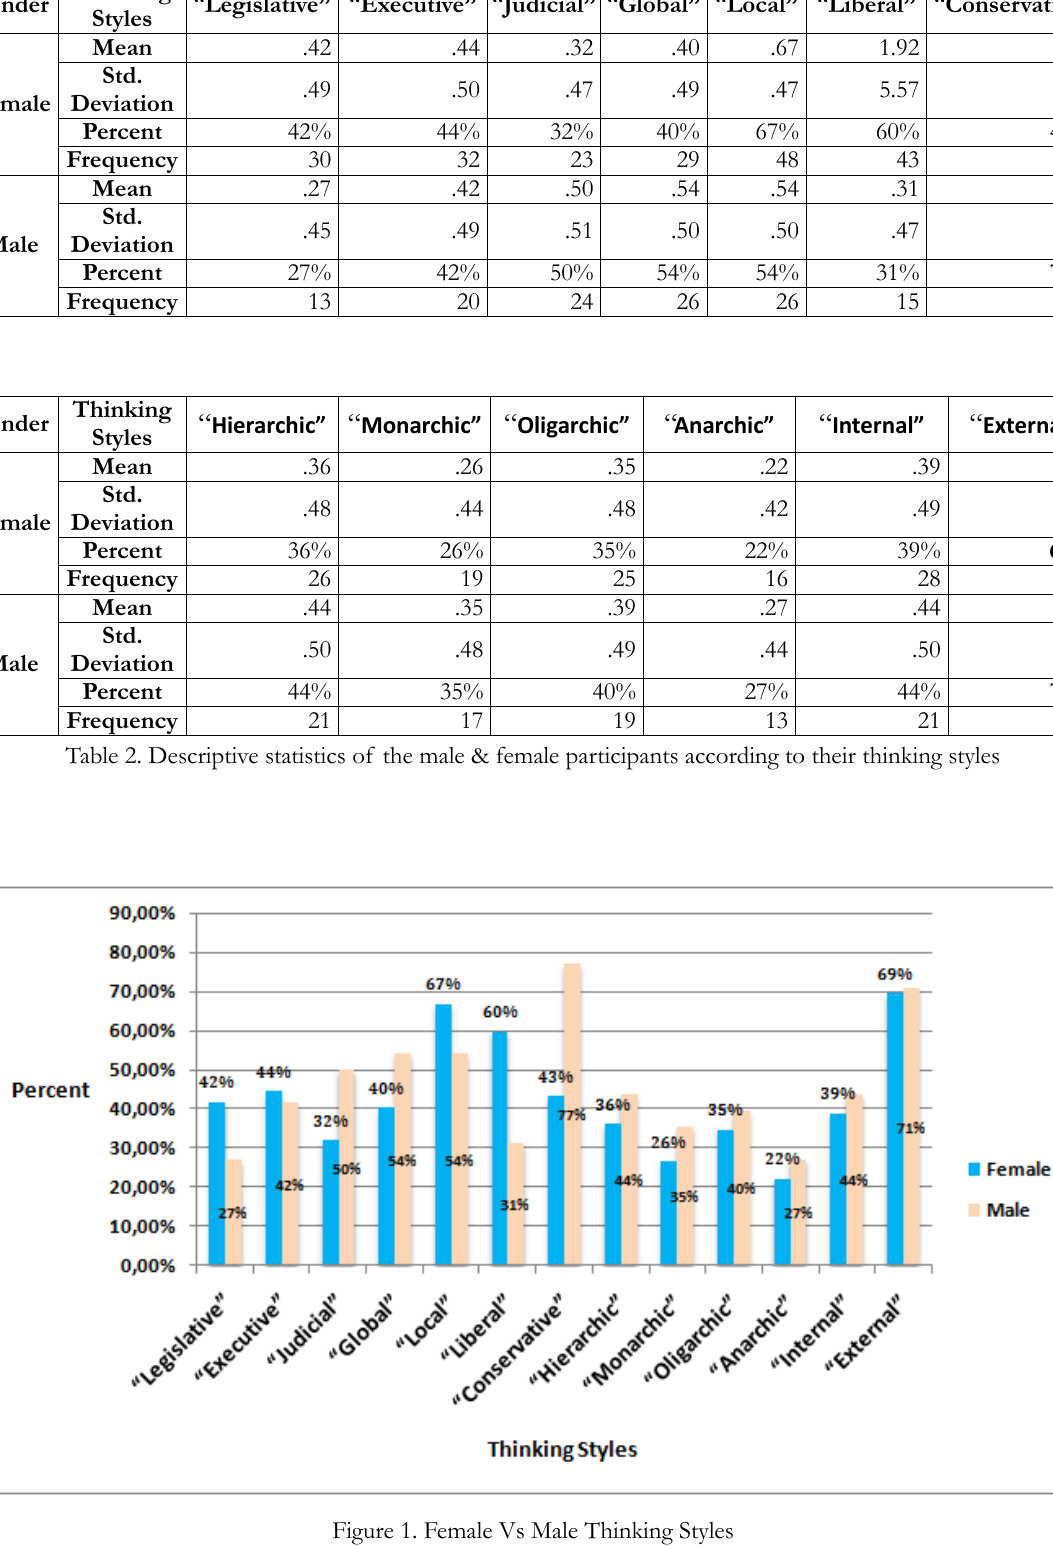
Figure 1. Female Vs Male Thinking